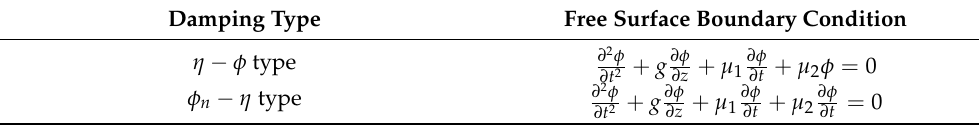
Table 2. Free surface boundary conditions with two different types of artificial damping